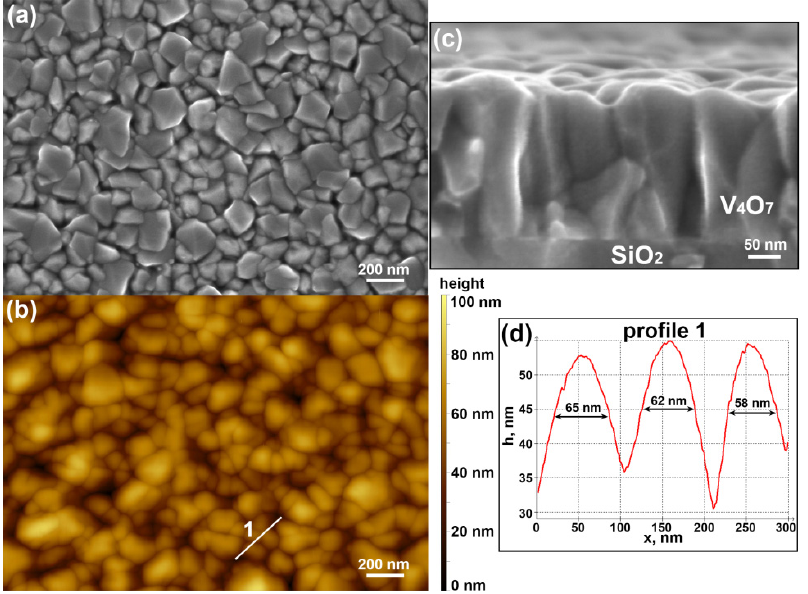
Figure 3. Morphology of V 4 O 7 film. ( a ) SEM and ( b ) AFM images of the sample surface. ( c ) SEM image of the sample cross-section. ( d ) Height profile measured by AFM along the white line 1 in Figure 3b.